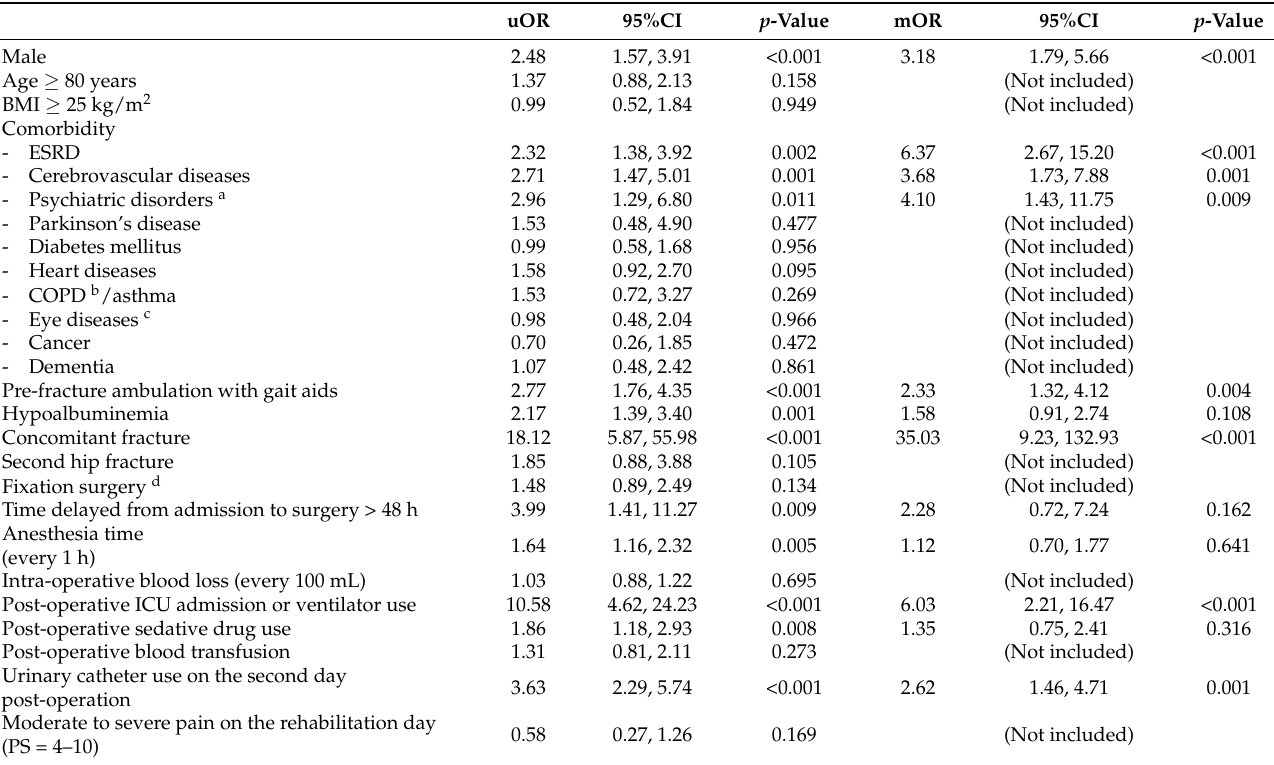
Table 2. Univariable and multivariable association between pre-, intra-, and post-operative predictors and the inability to bear self-weight at discharge in patients with fragility femoral neck fractures.